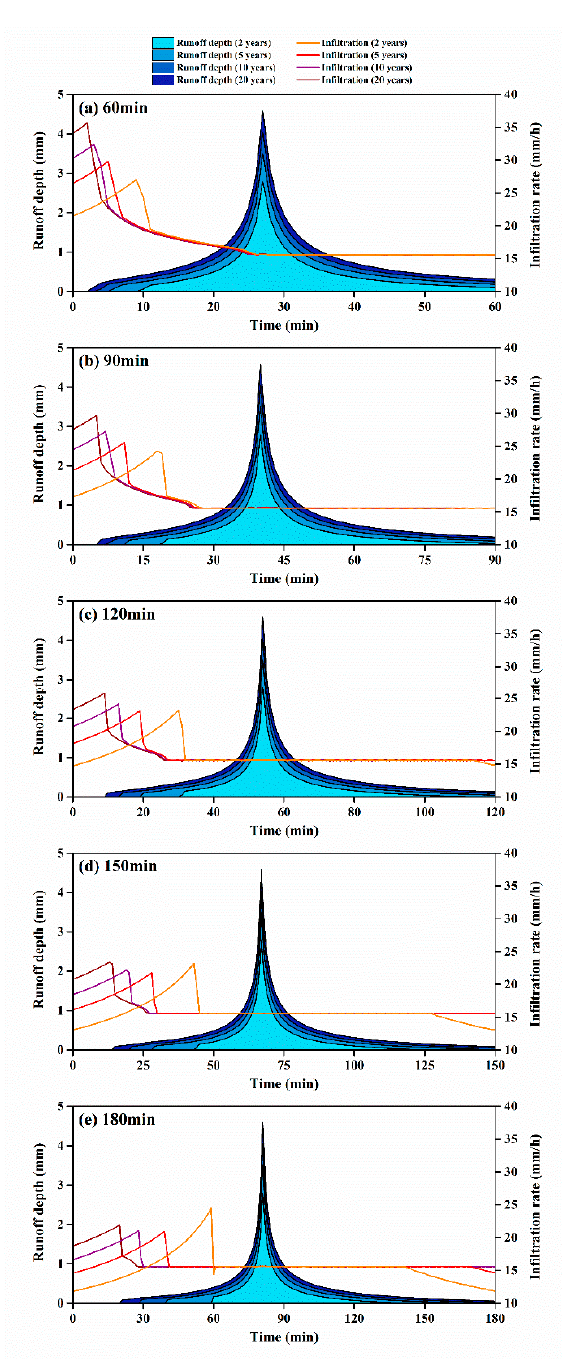
Figure 5. Runo ff depth (RD) and infiltration rates (IR) of a permeable pavement system during design rainstorms with durations of ( a ) 60 min; ( b ) 90 min; ( c ) 120 min; ( d ) 150 min, and ( e ) 180